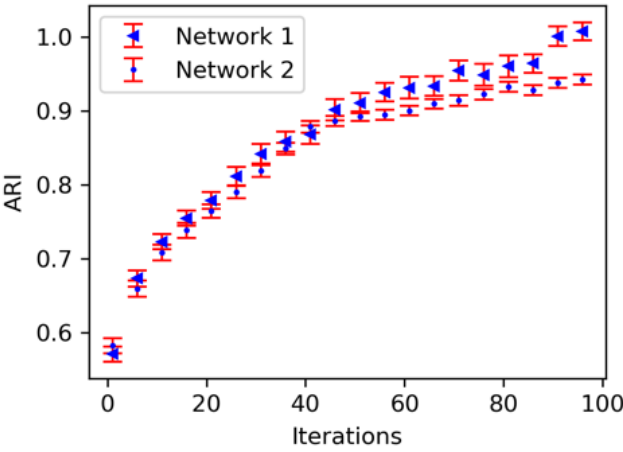
Figure 6. The classification result with MDND of Networks 1 and 2 with the increase of the iteration. It can be seen that as the iteration times increases, the ARI value gradually approaches 1, and the volatility is